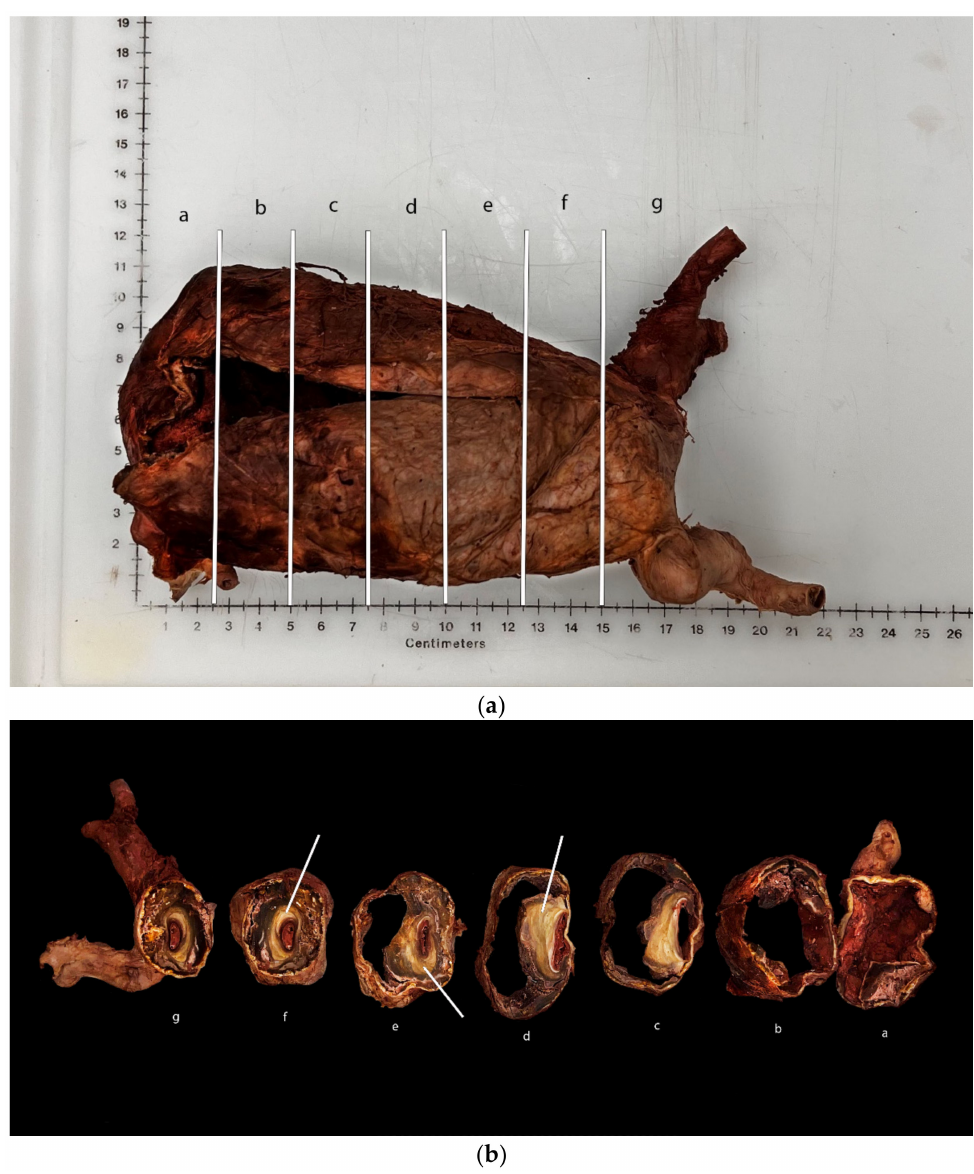
Figure 3. ( a ) White lines on AAA represent where the slices were made to create ( b ). Labels a–g correlate to the slices in ( b ). ( b ) Cross-sectional view of the abdominal aortic aneurysm. Layers of atherosclerosis (marked by white arrows) and calcification are observed. A small area for blood flow is marked by a red thrombus towards the center of the first four